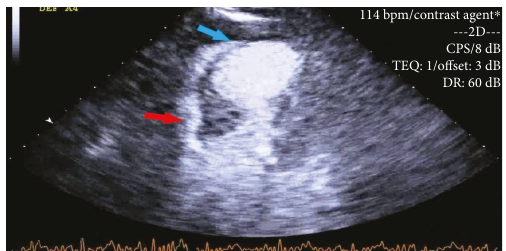
114 bpm/contrast agent ⁎ ---2D---